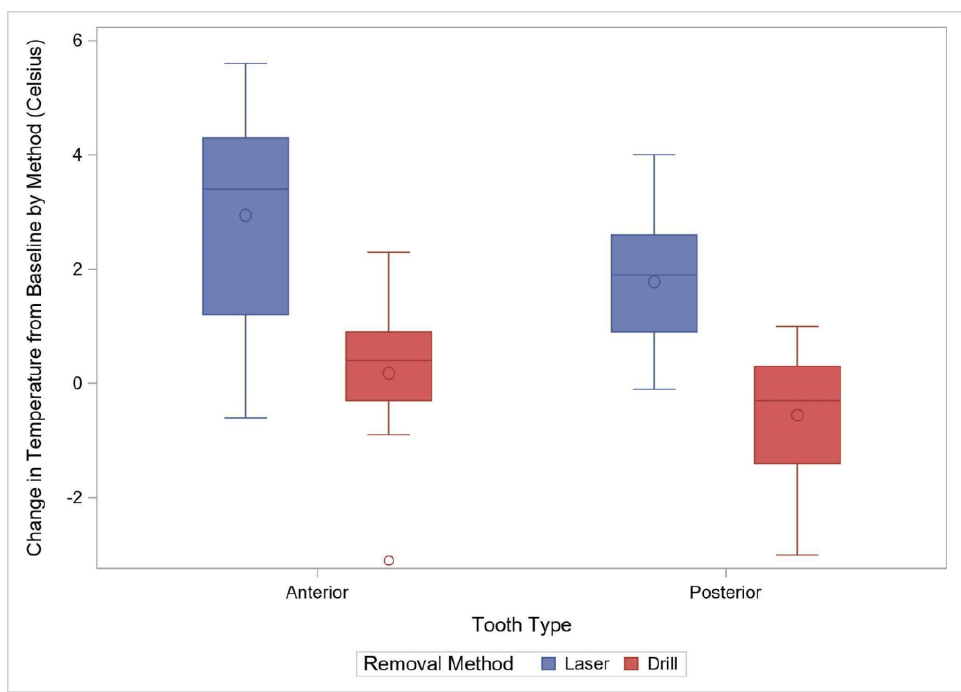
Figure 3. Comparison of Maximum Observed Temperature by Method for Anterior Primary and Posterior Permanent Teeth. The box plots demonstrate 95% confidence interval with “o” within the box plot representi ng a mean value, and “o” outside the box plot representing an outlier.